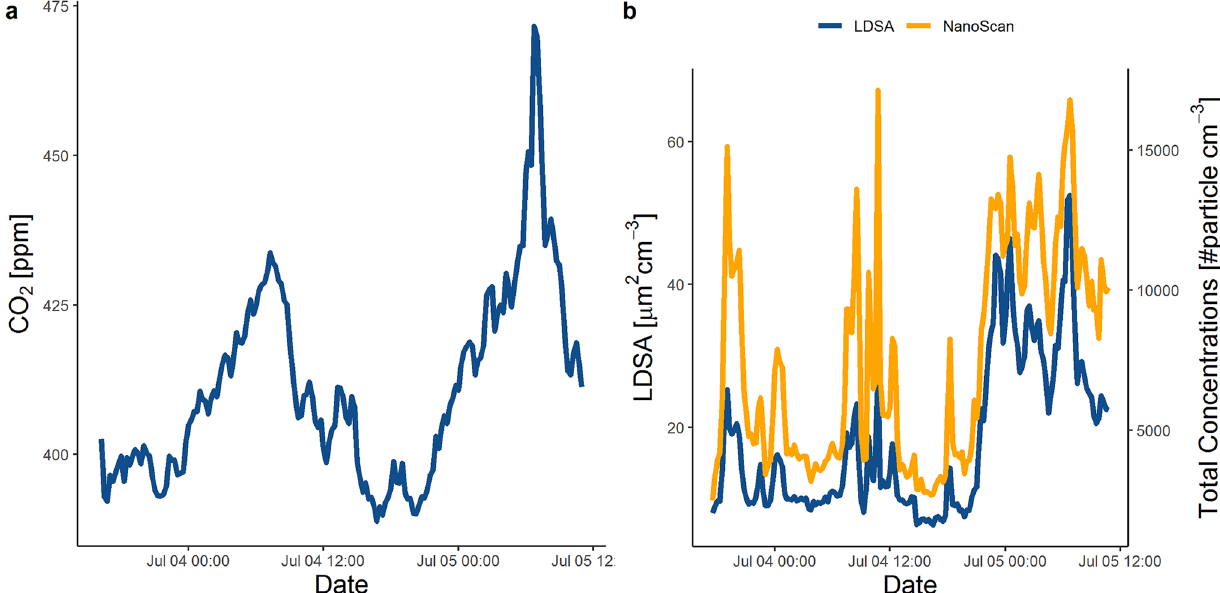
and the orange line is the total number concentration of particles Fig. 4 Concentrations of CO , LDSA and total particle number 2 between 9 and 420 nm. The data are presented as 15 before, during, and after fireworks. a CO concentration in ppm. 2 b The blue line represents the lung deposited surface area (LDSA)